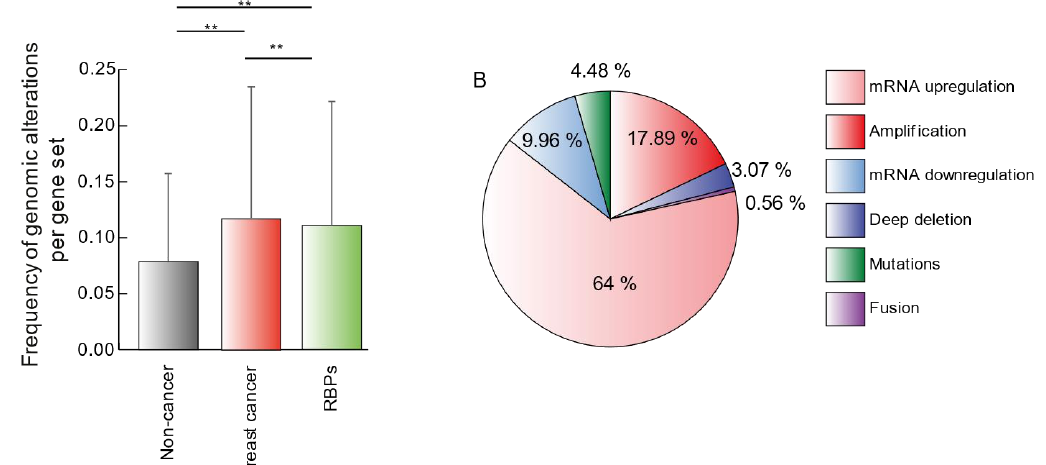
Figure 2. Genomic alterations of RBPs in BC. ( A ) Frequency of genomic alterations per gene set (non-cancer genes ( n = 170), BC genes ( n = 171), and RBPs [ n = 1392]) using the Breast Invasive Carcinoma (TCGA, PanCancer Atlas) and Breast Cancer (CPTAC) database [5 – 10,35]. Genomic alterations per patient were corrected by the number of genes; a Mann – Whitney U test was used to compare genomic alterations between gene sets. ** = very significant difference; ns = not significant. ( B ) A pie chart describing RBPs' genomic alteration types.